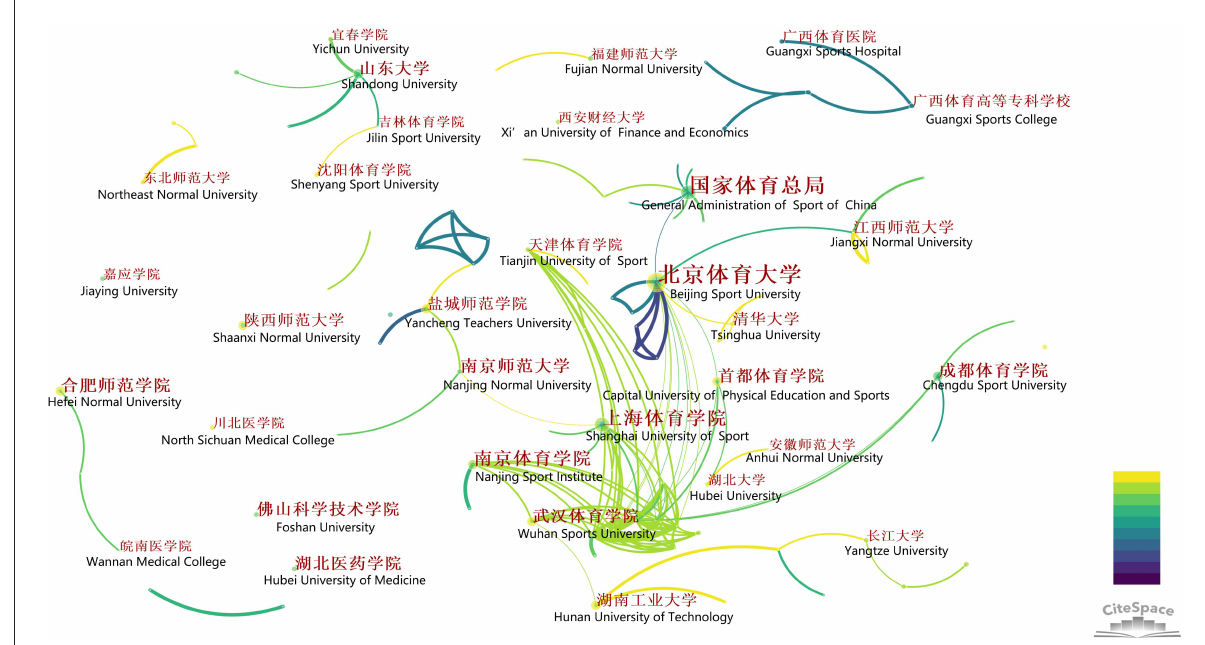
FIGURE2 Bibliometric analysis of the institutions of publications on fusion of sports and medicine in China from 2012 to 2021. Each node represents a institution, the bigger the node the institution had more publications. The line indicated the relationship between institutions, the thicker the closer relationship, the lighter the later cooperation were formed. The English was translated from the original figure yielded by